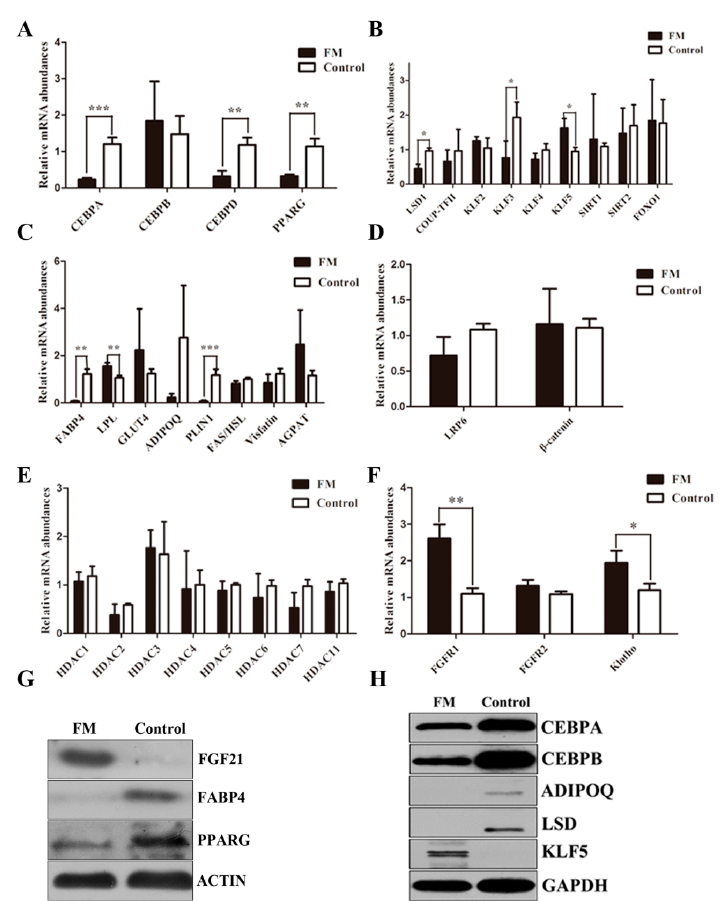
Figure 5. FGF21 reduced the adipogenesis-related genes expression on the cell differentiation 8th day. The qRT-PCR analysis of CEBP family and PPARG ( A ); The genes expression regulating CEBP family and PPARG ( B ); adipokines ( C ); Wnt signal ( D ); HDAC family ( E ) and FGFRs signal ( F ) on the cell differentiation 8th day. Gene expression was normalized with GAPDH . Data was presented as mean ± SD, * for 0.01 < p < 0.05, ** for 0.001 < p < 0.01 and *** for p < 0.001; Western blot analysis of the adipogenesis-related genes on the cell differentiation 8th day. The gene expression was normalized with ACTIN ( G ) and GAPDH ( H ).